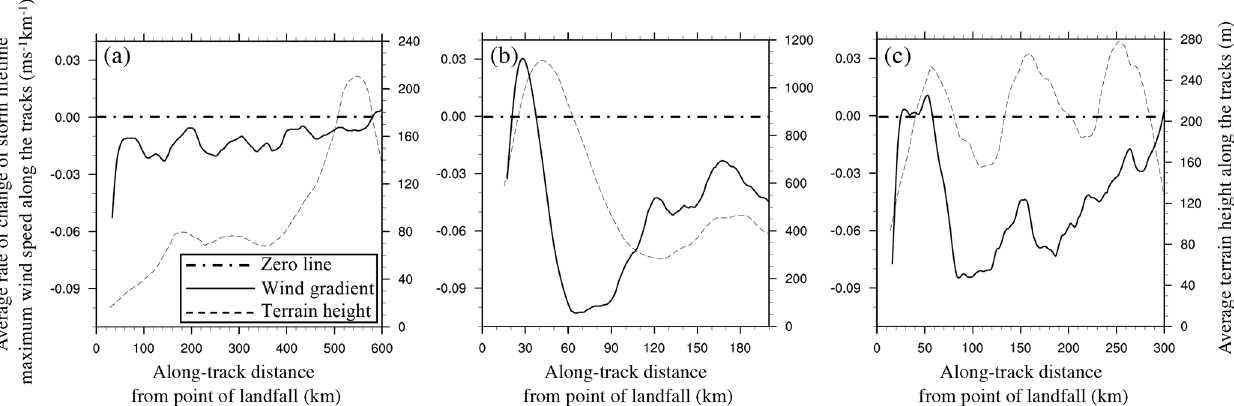
Figure 7. Variation of regional average distance rate of change of wind speed (ms − 1 km − 1 ) and terrain height (m) with along-track distance from the point of landfall (km) for the same regions as shown in Fig. 6; (a) Gulf of Mexico and southeastern US, (b) eastern China and Taiwan, and (c) eastern Australia. All data are smoothed using a 30 point running average. Region-average values are calculated over all tracks within each region. The x axes (along-track distance) are cut off at the point where only three tracks remain. Each panel has the same left- y -axis limits but different right- y -axis limits to better show the ranges of regional terrain height.